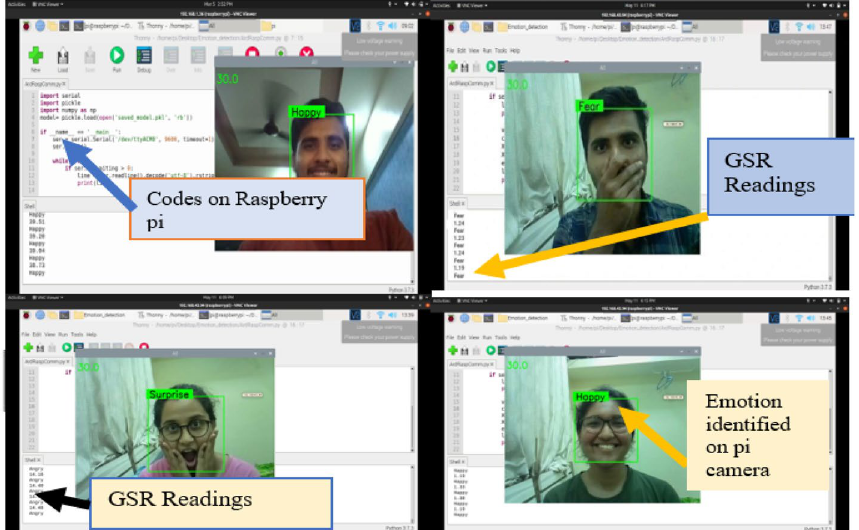
Fig. 12 The overall appearance of the screen when the participant is experiencing diverse video stimuli in laboratory conditions (4 different screens captured shown all in